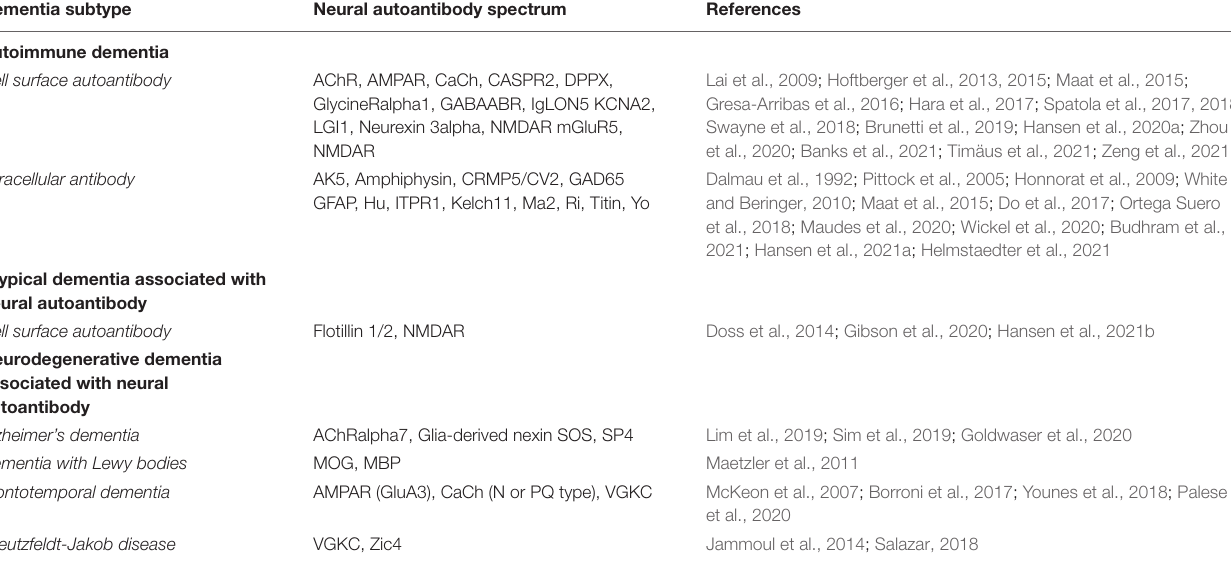
TABLE 1 | Neural autoantibody-associated dementia and cognitive